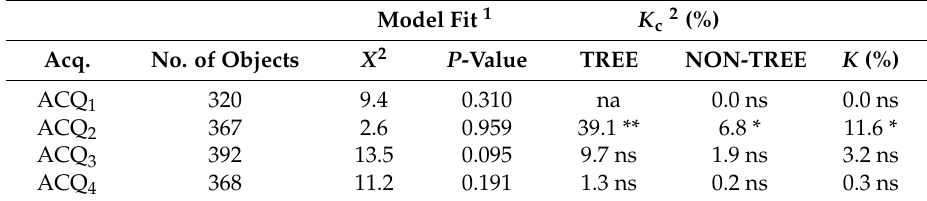
Table 5. Model fit and results of leave-one-out cross validation of the logistic regression models with binary response fitted according to Equation (2). Only objects with at least one echo with h > 0 are